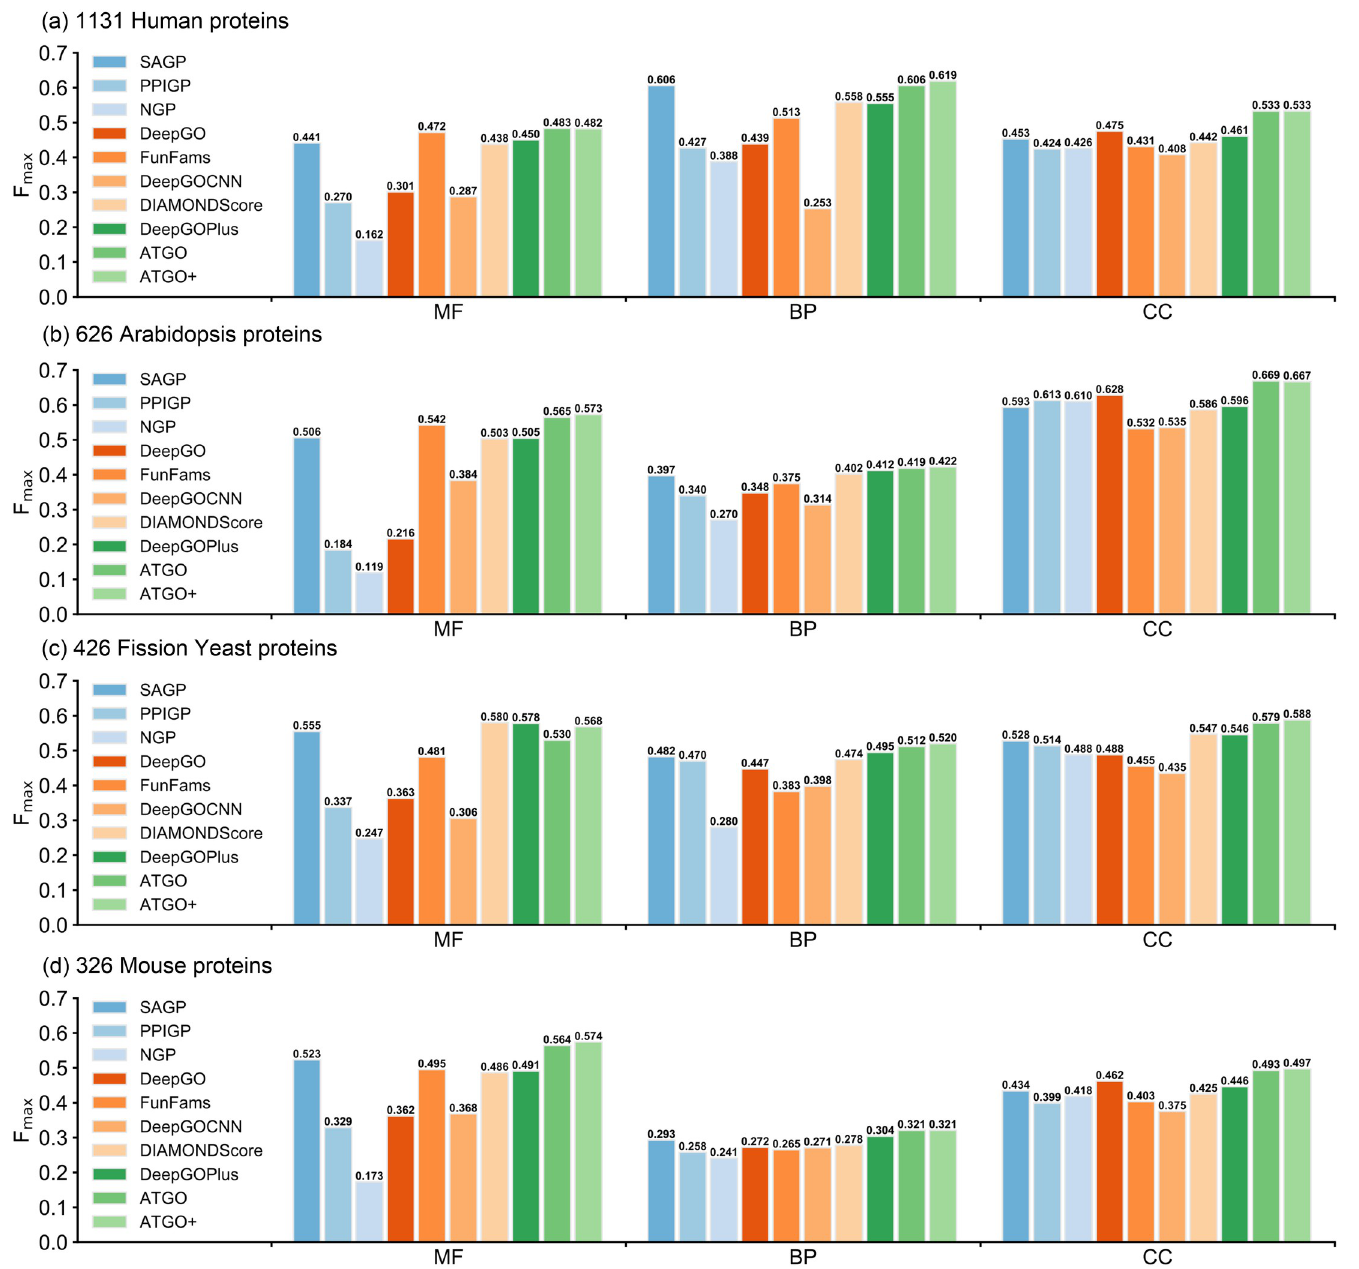
Fig 4. The F max values of 10 GO prediction methods under the homology cut-off t 1 = 30% between training and testing proteins for four individual species in CAFA3 test dataset. (a) Human; (b) Arabidopsis; (c) Fission Yeast; (d) Mouse.